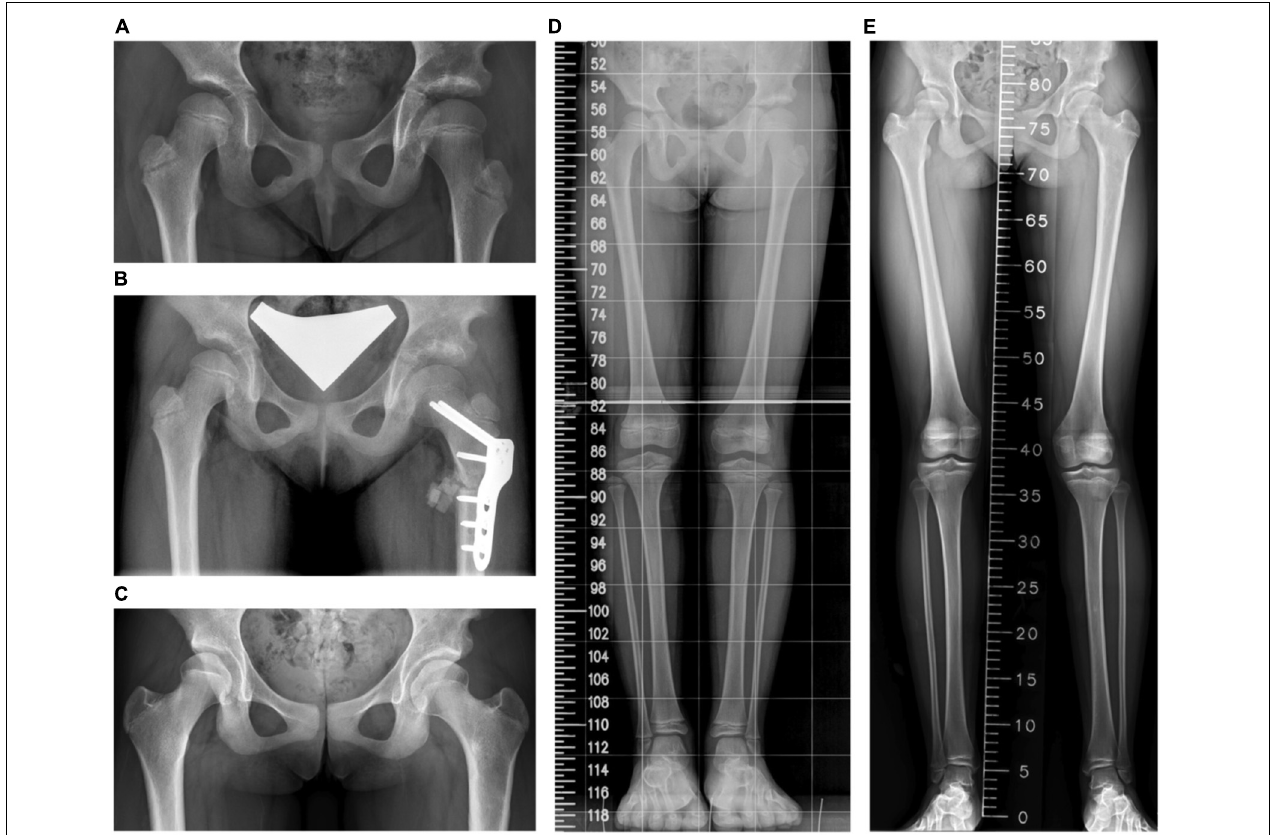
FIGURE 4 | A girl who had open reduction and Pemberton procedure for left hip developmental dysplasia of the hip (DDH) earlier underwent the proximal femoral osteotomy for coxa valga. (A) A preoperative standing pelvis anteroposterior view. (B) A postoperative standing pelvis anteroposterior view. (C) The latest standing pelvis anteroposterior view 61 months after the operation. (D) A preoperative scanogram. (E) The latest scanogram 61 months after the